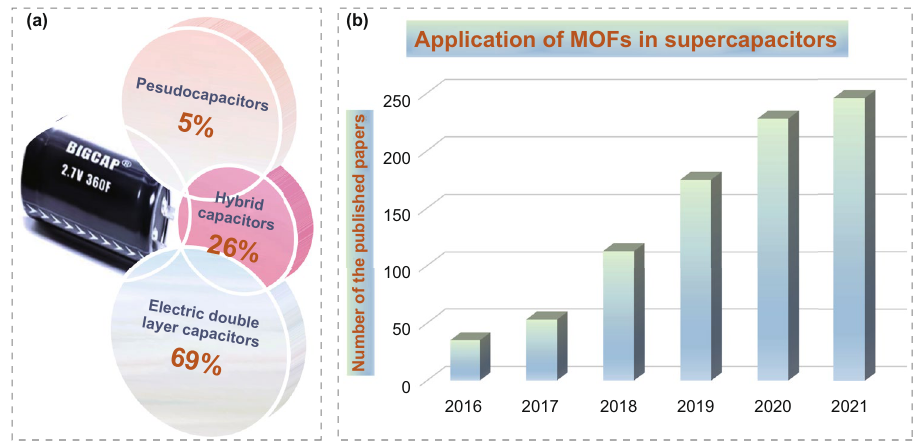
Fig. 2 a Publications of the ratio of MOFs used in three types of supercapacitors. Data from Web of Science using the keywords “metal–organic framework, double-layer capacitors, faraday pseudocapacitors, and hybrid capacitors.” b Publications of MOFs application in supercapacitors. Data from Web of Science using the keywords “metal–organic framework,